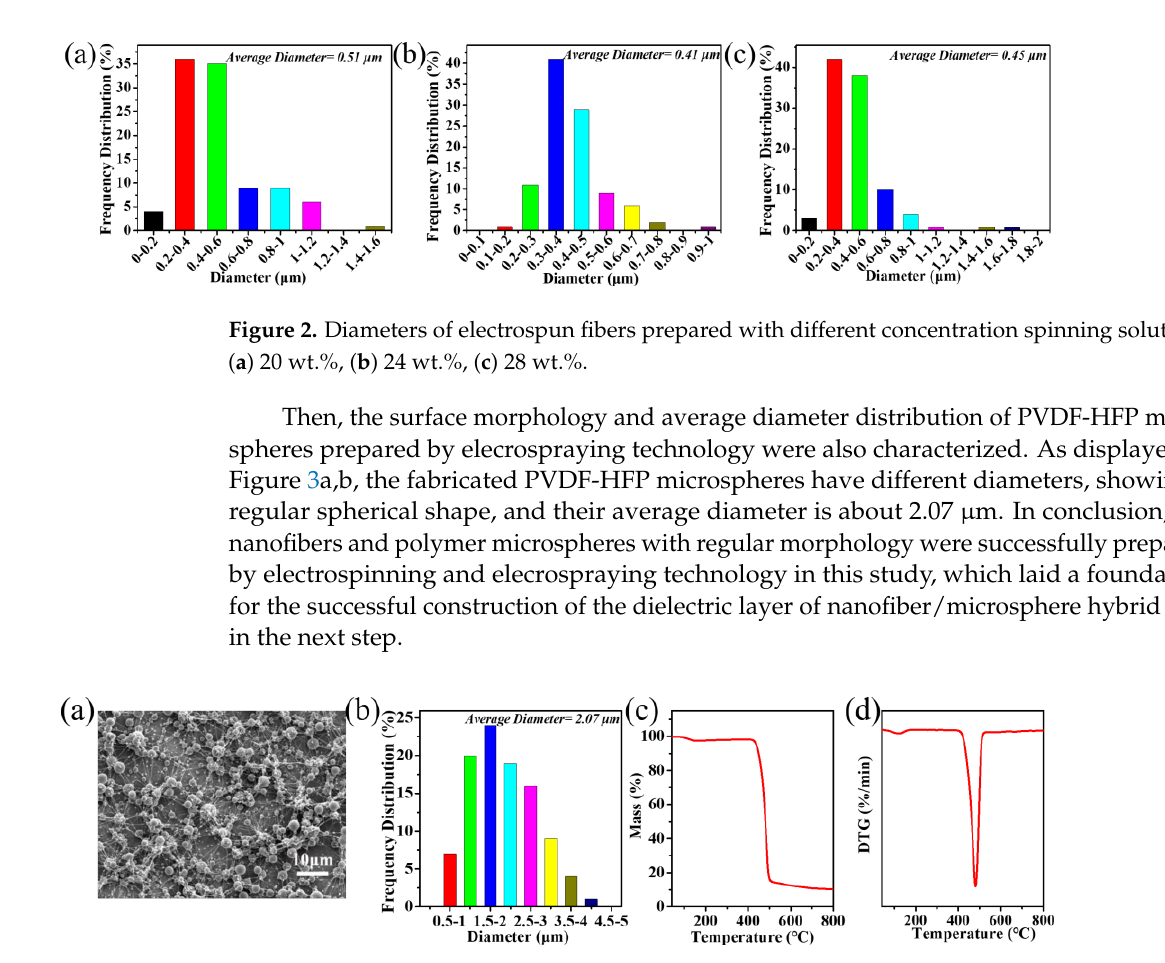
Figure 1. SEM micrographs of electrospun fibers prepared with different concentration spinning solutions. ( a ) 12 wt.%, ( b ) 20 wt.%, ( c ) 24 wt.%, ( d ) 28 wt.%.